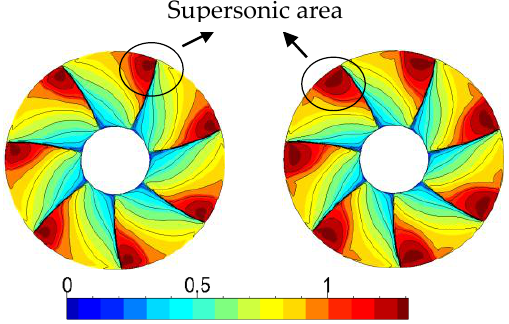
Figure 7. Relative Mach number distribution at the inlet of the impeller ( left : 0 m right : 4500 m).